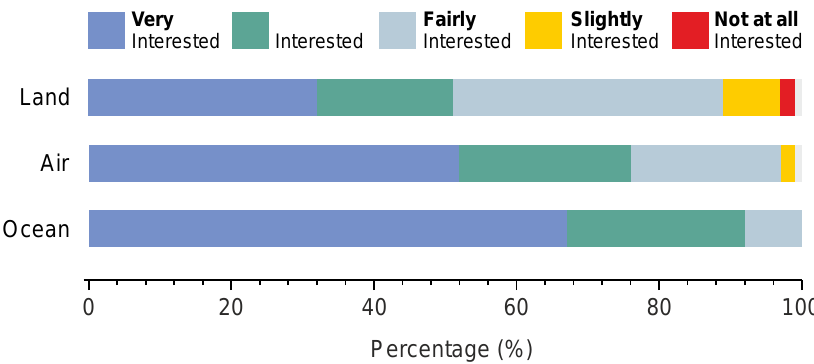
Figure 6. Levels of participants’ interests for phenomena falling under land, air, and ocean categories of satellite visualizations.